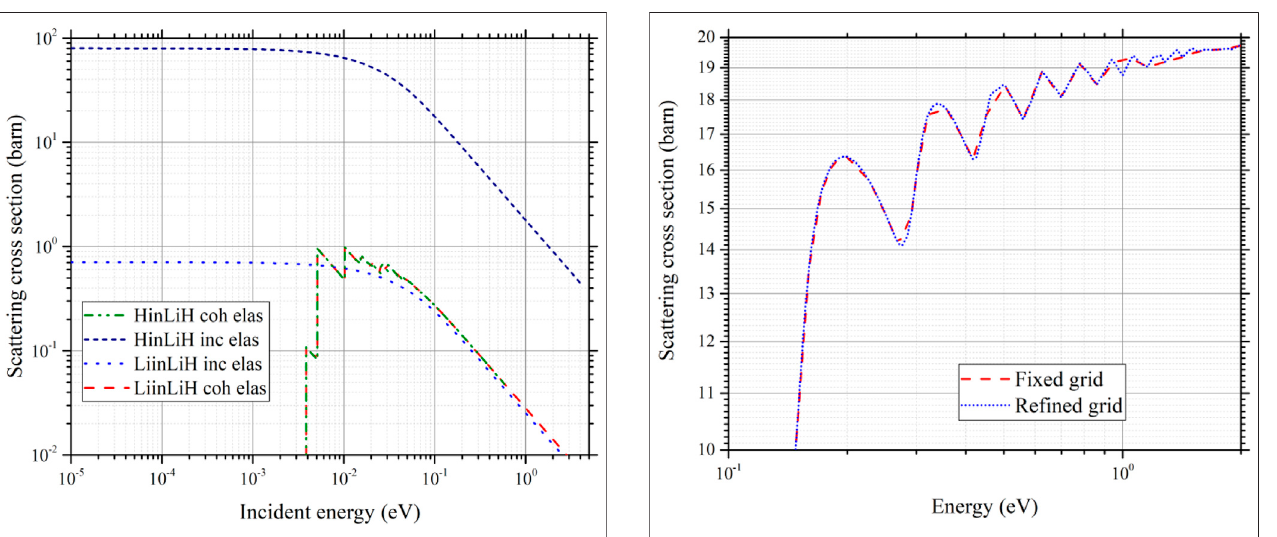
FIGURE6| Detailsofinelasticscatteringcrosssectionof δ -ZrH 1.5 above 0.1 eV.